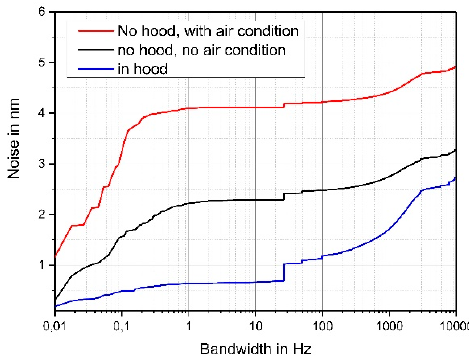
Figure 3. Influence of laboratory air conditioning and usage of an acoustic shielding hood on the measured noise of a 5-mm long microprobe.